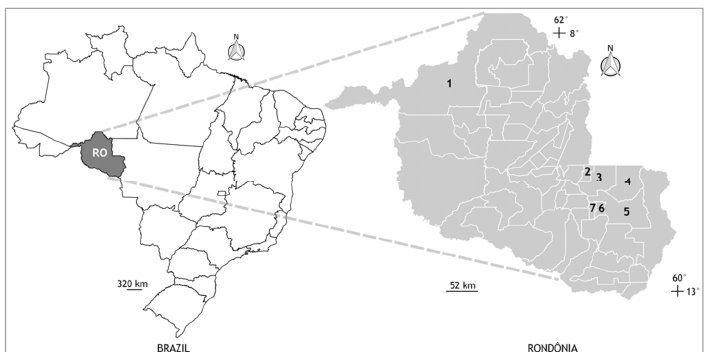
Figure 1. Geographic location of the municipalities of Porto Velho (state capital) and Cacoal (site of the National Health Foundation sexually transmitted infections clinic), state of Rondônia (RO), northern Brazil. All sample and personal data collections from the participants were carried out in the city of Cacoal, but some participants lived in other nearby locations. Municipalities: (1) Porto Velho, (2) Cacoal, (3) Espigão D'Oeste, (4) Ministro Andreazza, (5) Pimenta Bueno, (6) Primavera de Rondônia, and (7) São Felipe.